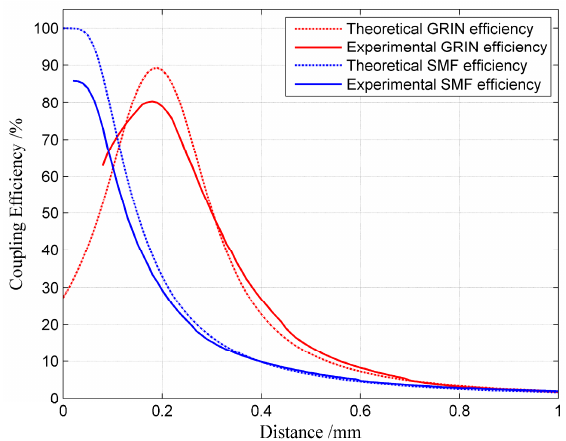
Figure 6. Theoretical and experimental values of coupling efficiency.